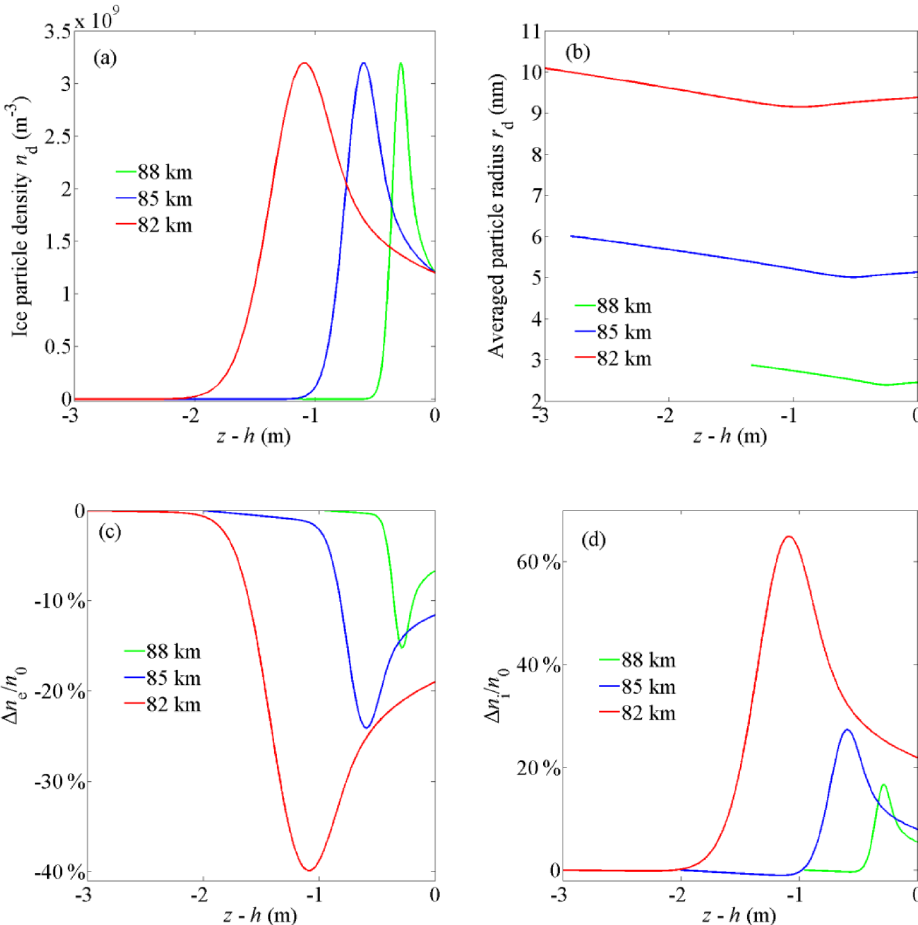
Figure 12. The distribution of (a) ice particle density, (b) the averaged particle radius, (c) the relative change of electron density (cid:49)n e /n e , and (d) the relative change of ion density (cid:49)n i /n i at various altitudes near the upper boundary of the condensation